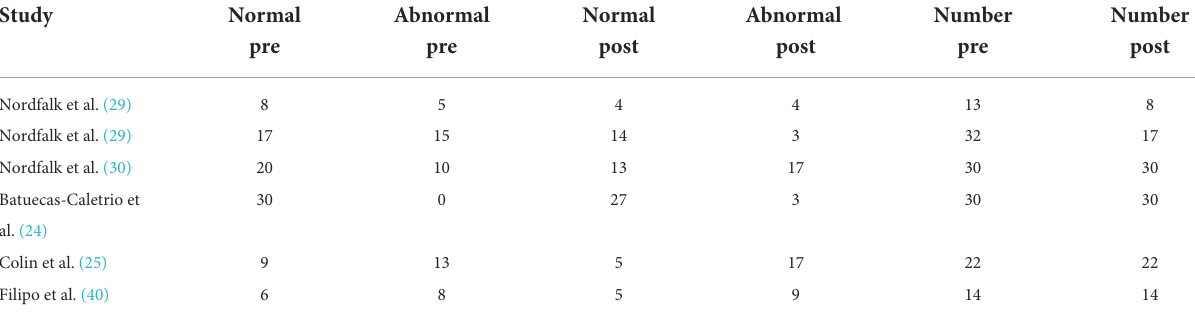
Normal pre, number of people with normal test results before surgery; Abnormal pre, number of people with abnormal test results before surgery; Normal pós, number of people with normal test results after surgery; Abnormal pós, number of people with abnormal test results after surgery; Number pré, number of people tested before surgery; Number pós, number of